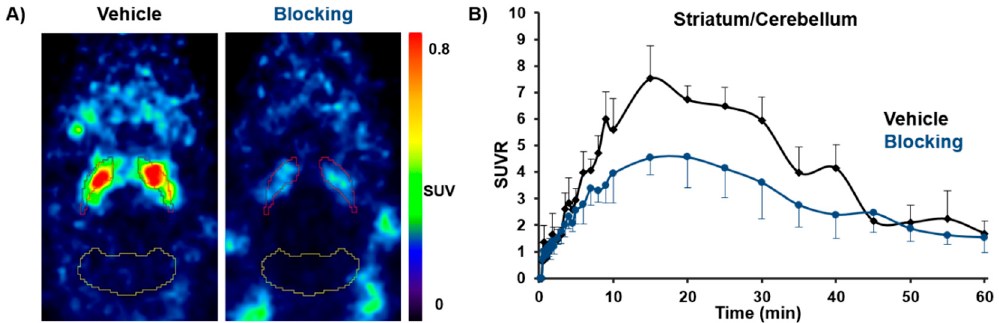
Figure 4. ( A ) Representative horizontal PET images of [ 18 F] FESCH uptake (average 10–30 min) in the brain of healthy CD-1 mice under vehicle (15 min pre-injection of DMSO:Kolliphor ® EL:0.9% NaCl, 1:2:7, 5 µL/g) and blocking conditions (15 min pre-injection of tozadenant 2.5 mg/kg in DMSO:Kolliphor ® EL:0.9% NaCl, 1:2:7, 5 µL/g; red = striatum; yellow = cerebellum). ( B ) Averaged TACs of [ 18 F] FESCH for vehicle (n = 4) and tozadenant pre-injected mice (n = 4) with SUVRs for striatum over cerebellum.